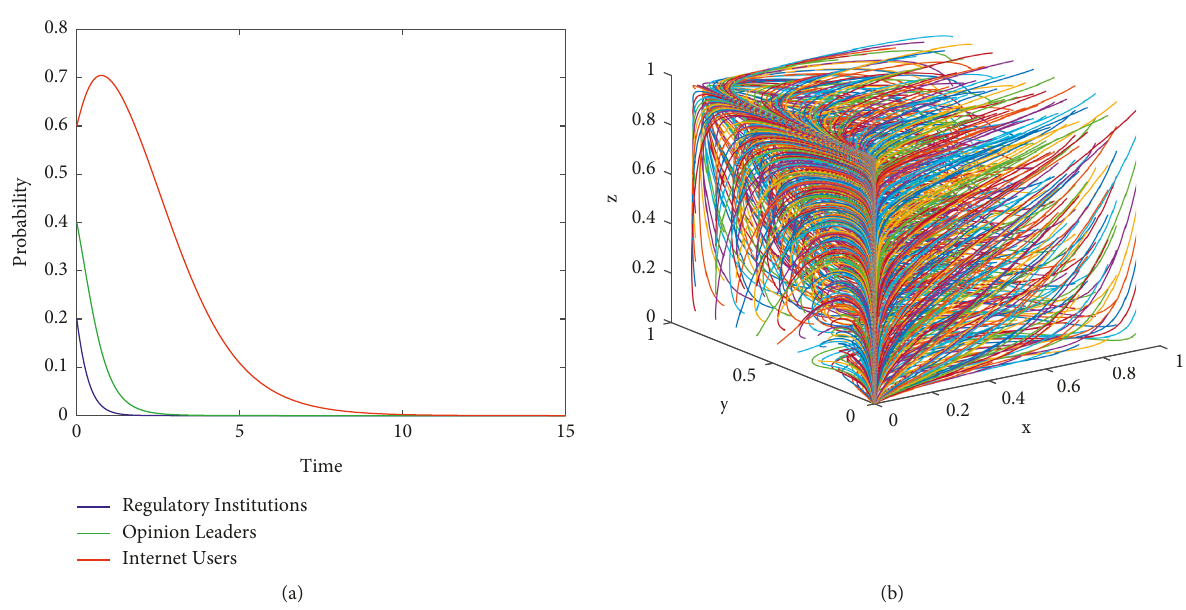
Figure 1: Tripartite evolutionary game trending figure stable at point E 1 (0,0,0) between “regulatory institutions, opinion leaders and Internet users.” (a) Strategy selection process. (b) 3D simulation diagram of the